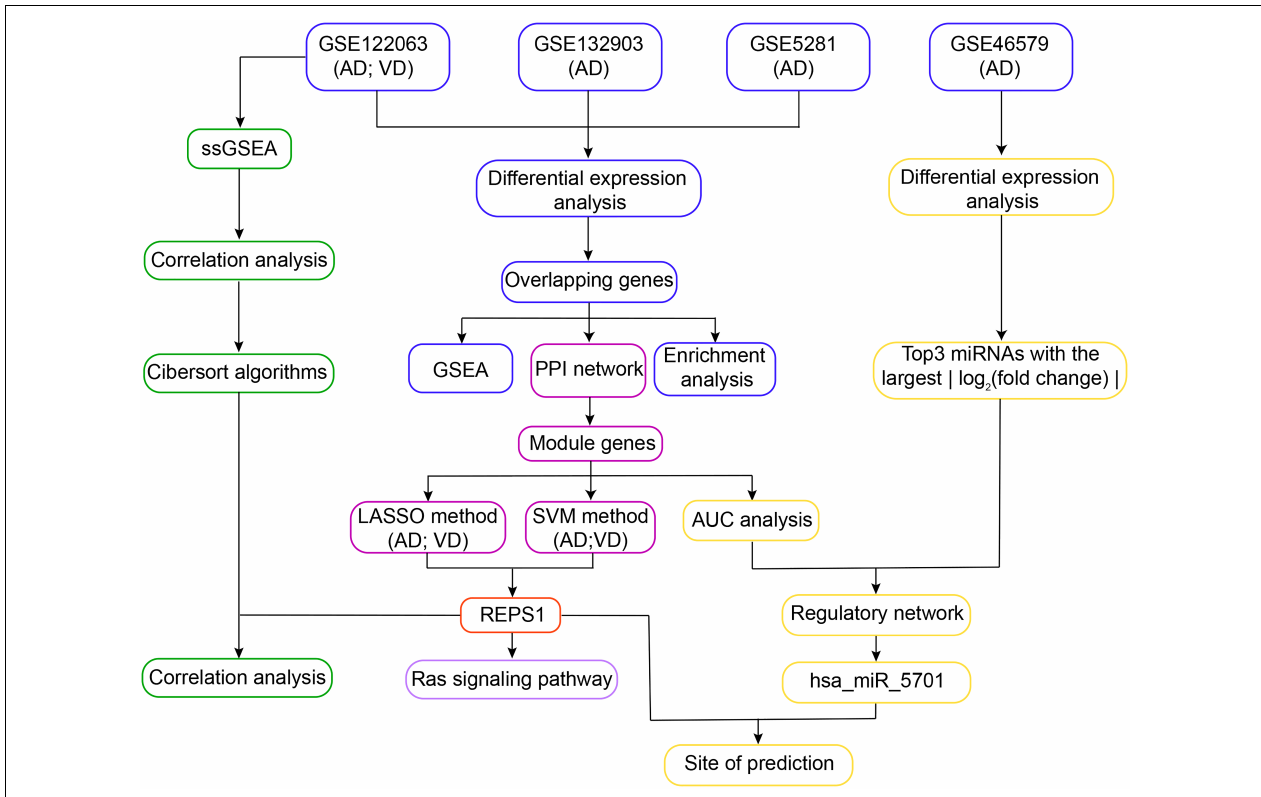
FIGURE 1 | Workflow of the study. In Step 1, differentially expressed genes in Alzheimer’s disease (AD) and vascular dementia (VD) were identified in three datasets (GSE122063, GSE132903, and GSE5281). The differentially expressed genes overlapping across all three datasets were subjected to functional enrichment analysis and gene set enrichment analysis (GSEA). In Step 2, overlapping differentially expressed genes were used to construct a protein–protein interaction (PPI) network, leading to identification of module genes. REPS1 was identified as a hub gene using the least absolute shrinkage and selection operator (LASSO) and the support vector machine-recursive feature elimination (SVM-RFE) algorithm. In Step 3, module genes and the three differentially regulated microRNAs (miRNAs) showing the largest | log 2 (fold change)| were used to construct a regulatory network. We found evidence that REPS1 binds hsa_miR_5701. In Step 4, single-sample gene set enrichment analysis was performed on the expression profiles of AD and VD in GSE122063. We also explored immune cell infiltration and correlation between REPS1 and biological pathways in AD and VD. AUC, area under the receiver operating characteristic